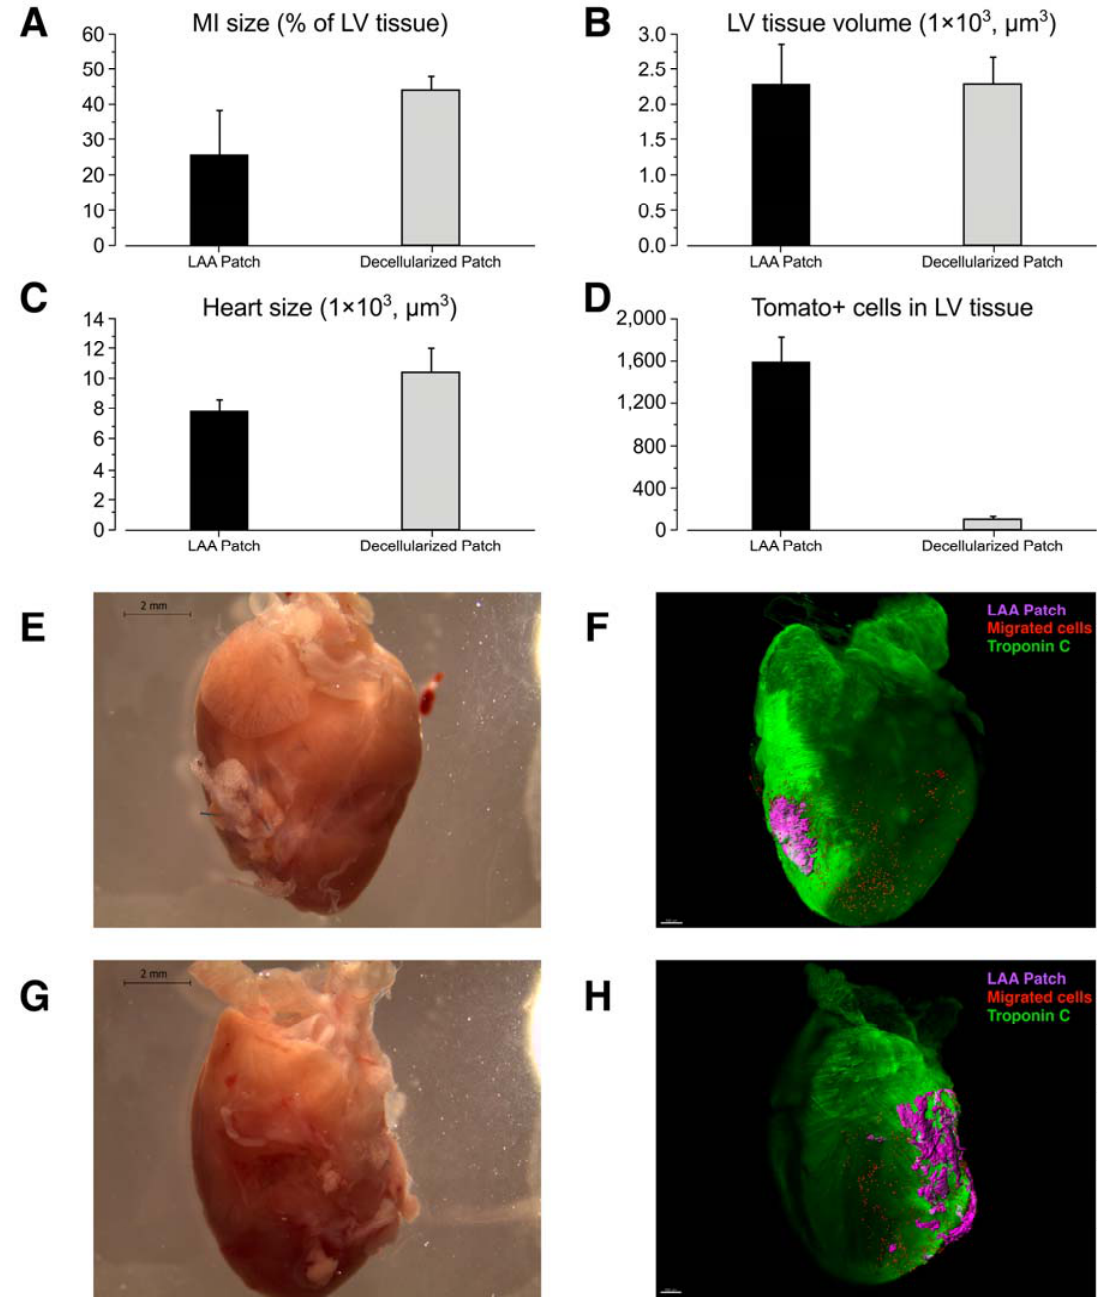
Figure 4. 3D analysis 8 weeks after the LAA transplantation. ( A ) Scar tissue size comparison of the LAA ‐ transplanted hearts ( n = 6) vs. the decellularized patch controls ( n = 6) demonstrating a smaller infarct area in the treated group. Scar volume is calculated by subtracting the troponin ‐ C ‐ positive signal from the autofluorescence of the left ventricle. Single measurements from the MI ‐ group and Sham ‐ group are shown as a reference. ( B ) Comparison of the size of the left ventricles after LAA transplants or the decellularized transplants before operation. ( C ) Heart tissue volume comparison of the LAA ‐ transplanted ‐ hearts vs. controls. Whole tissue volume of the hearts is calculated to evaluate the hypertrophic response. ( D ) Number of migrated mTomato+ cells compared to the control (false positive signal). ( E – H ) Whole mount images of the mTomato+ LAA ‐ transplant ‐ treated hearts. A comparison of light images and Imaris ‐ processed 3D images. E + F and G + H are from the same specimen. Autofluorescence (green); cells migrated from the transplant (red); LAA patch (magenta).